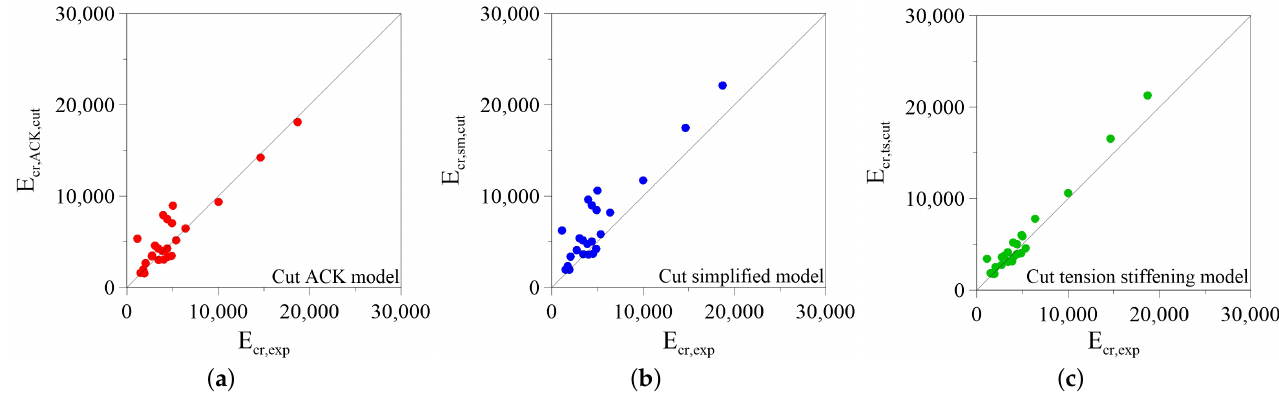
Figure 11. Comparison between experimental and analytical fracture energy, calculated by considering the maximum experimental elongation of the composite: ( a ) Cut ACK Model; ( b ) Cut Simplified Model; ( c ) Cut Tension Stiffening